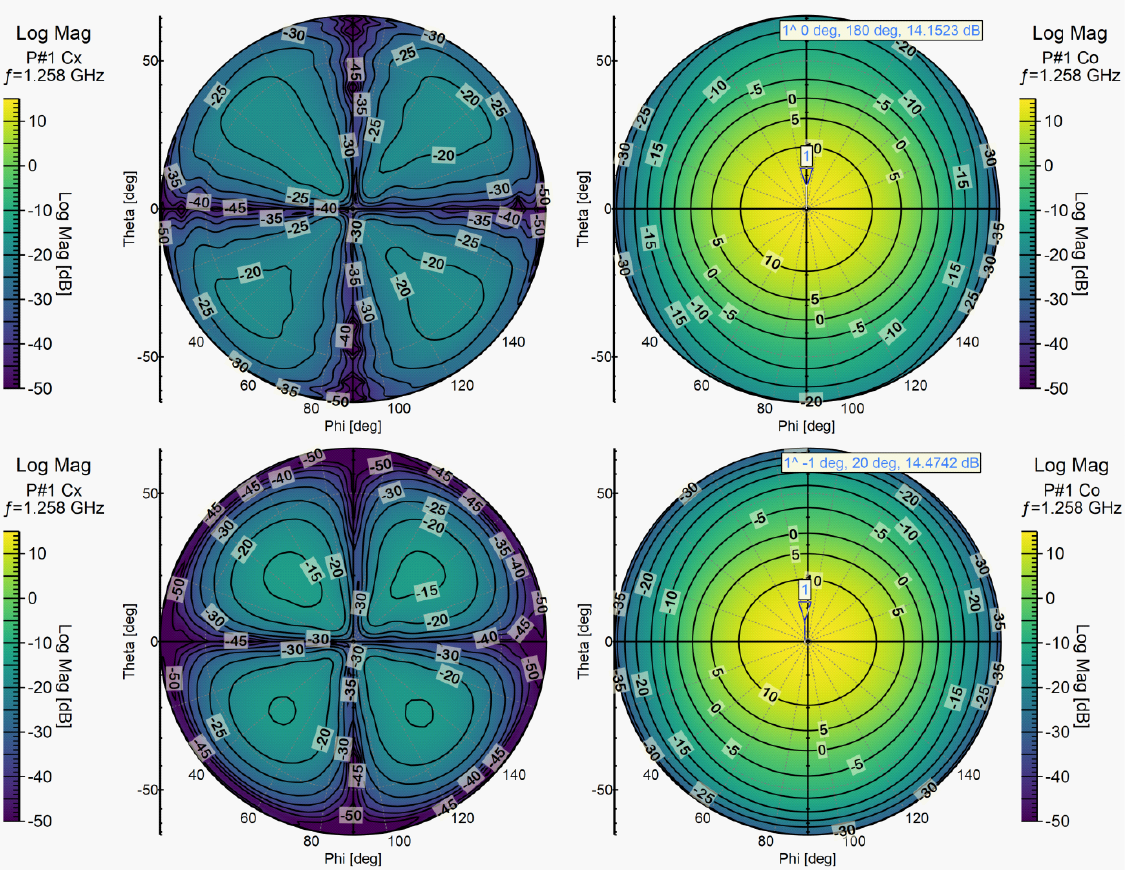
Figure 11. Measurement results for the horizontal polarization of one VEGA antenna without ( top ) and with choke rings ( bottom ) obtained through measurements in DLR’s CTR. The graphs show polar plots of the antenna’s far field split into the co-polarization (right) and cross-polarization (left) for both cases at the chosen frequency f sel = 1.2575GHz. In addition to the far-field pattern of the antenna, the changes in its near-field radiation were investigated and are shown in Figure 12.